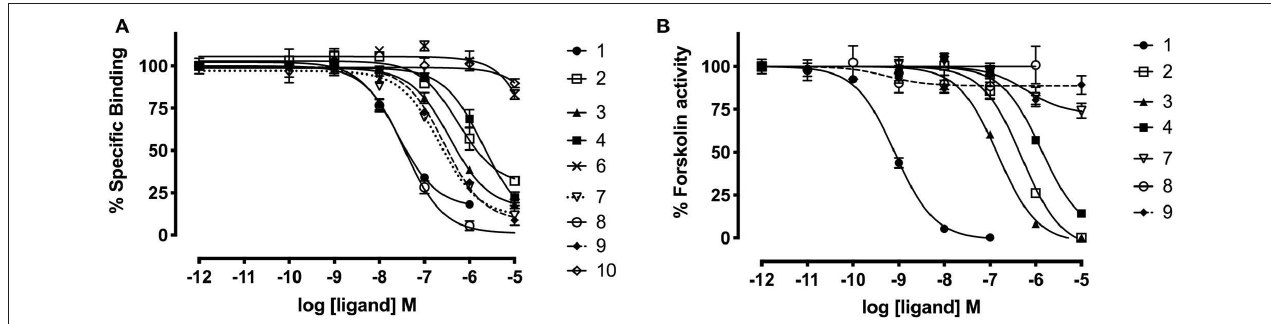
FIGURE 5 | Affinity and activity of relaxin-3 grafted agonists and antagonist at RXFP3. (A) Competitive binding curves for grafted peptides using CHO cells stably expressing RXFP3 and the fluorescent tracer Eu 3 + -R3B1-22R. (B) Activity of grafted agonists using a reporter assay in CHO cells stably expressing RXFP3. Activation is measured as a reduction in forskolin induced cAMP activity. Data are shown as mean ± SEM of triplicate determinations from a minimum of three independent experiments.